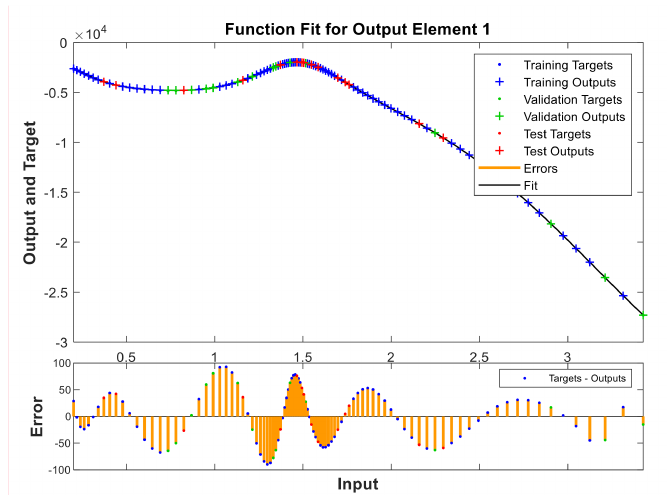
Figure 9. Unripe “Gordal Sevillana” at 25 ◦ C.